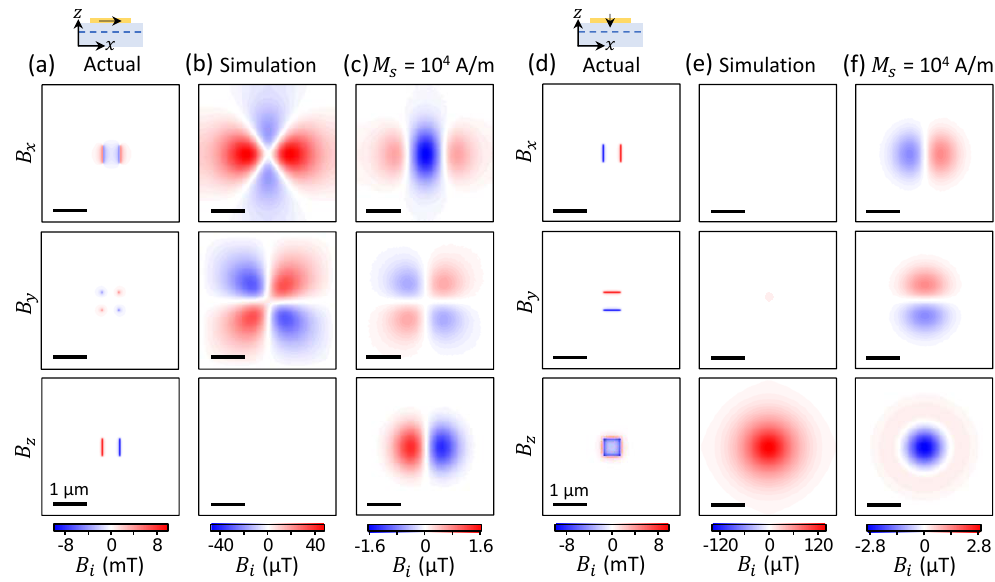
Figure 7. ( a ) Magnetic field calculated at a stand-off d = 20 nm for a 500 × 500 × 1 nm 3 flake magnetised along x with M s = 10 6 A/m (see schematic). ( b ) Apparent magnetic field obtained by simulating the full measurement process, with a stand-off d = 20 nm. ( c ) Same as ( b ) but M s = 10 4 A/m. ( d – f )